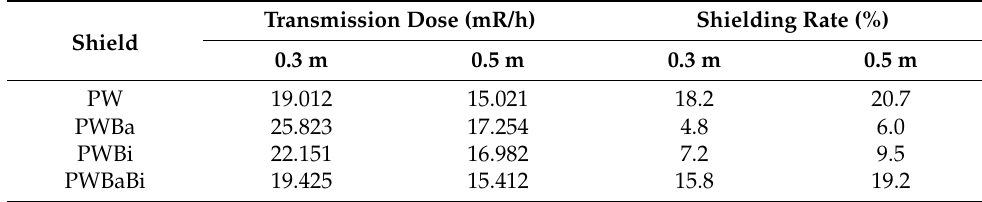
Table 4. Transmission dose and shielding rate of 18